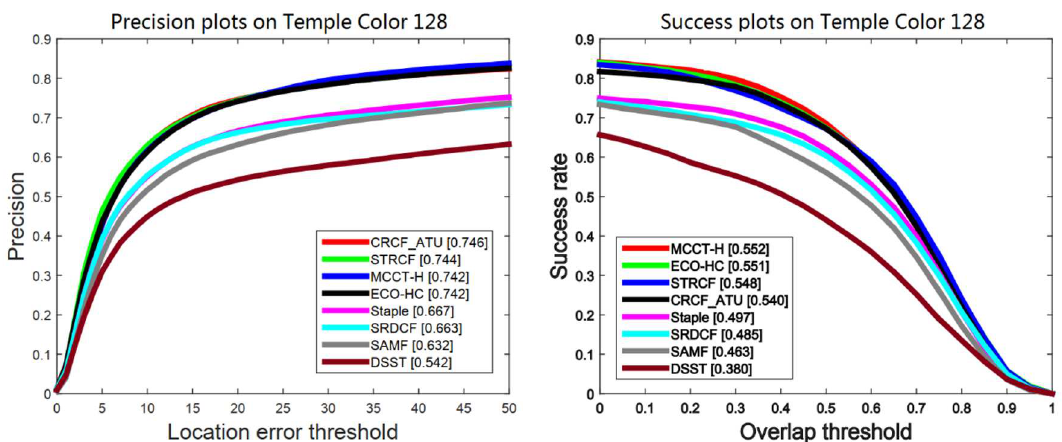
Figure 7. Comparison between our proposed CRCF_ATU tracker and existing trackers on Temple Color